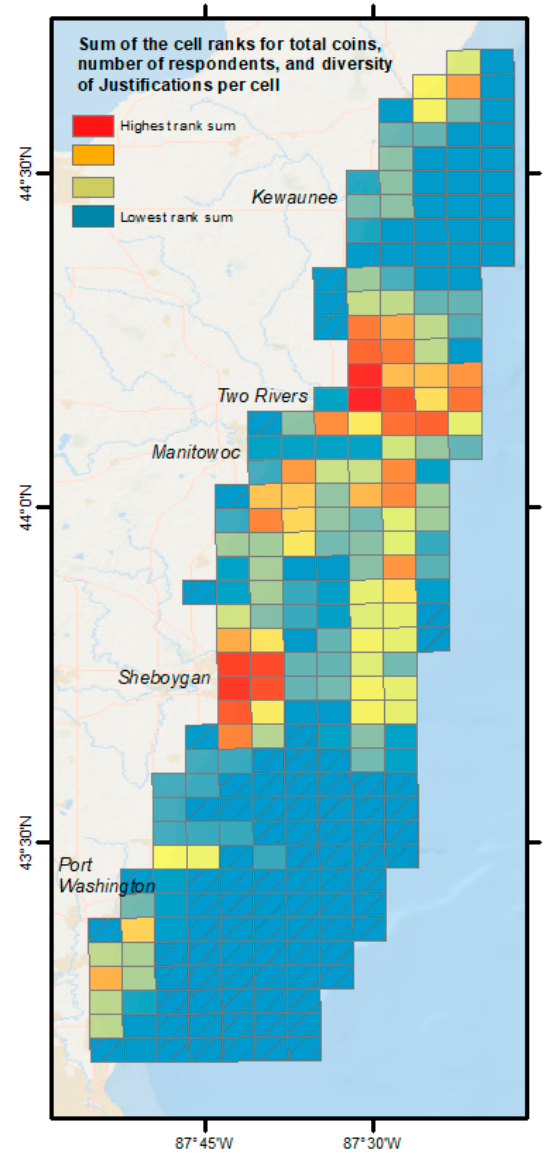
Figure 6. Sum of the cell ranks based on total coins, number of respondents, and diversity of Justifications in each cell. Cells receiving no coins are marked with diagonal lines.